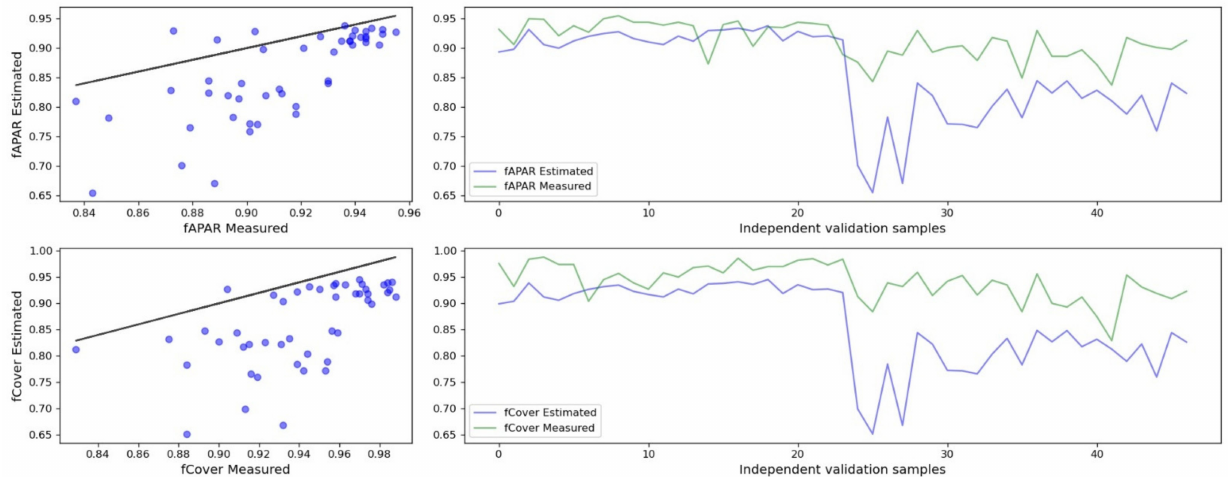
Figure 6. Relationship between observed and predicted biophysical variables. The predicted biophys- ical variables are from the best performing parametric model (3BSI-Wang and polynomial function). The black line is 1:1 line.